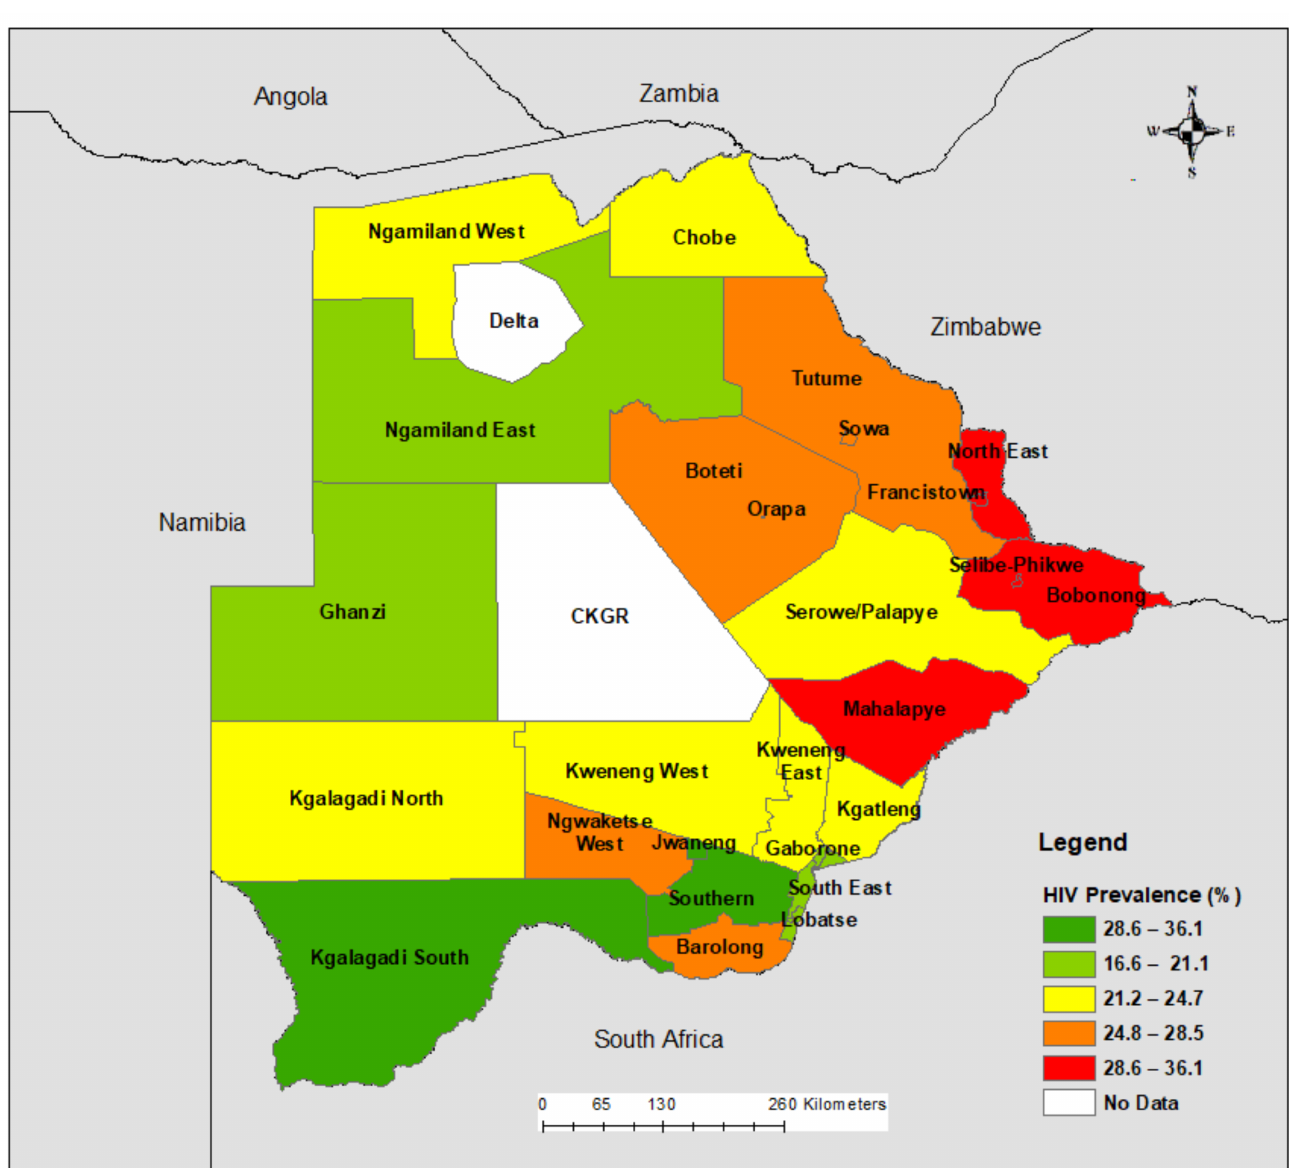
Figure 1. Crude HIV prevalence in adults by district in